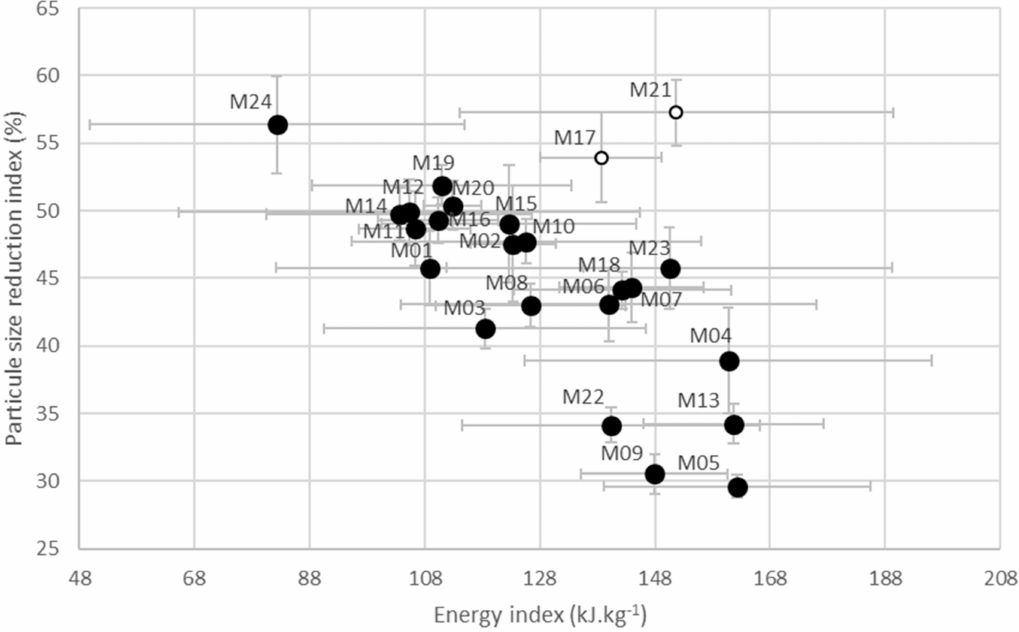
Figure 7. Particle Size Reduction index as a function of Energy Index for a collection of 24 maize inbred lines of maize. Table 2. Pearson correlation coefficients between friability indexes and the physical proper- ties and composition of 24 inbred lines of maize. Hemicellulose content = (NDF(% dm) − ADF(% dm))/NDF(% dm); Cellulose content = (ADF(% dm) − ADL(% dm))/NDF(% dm).